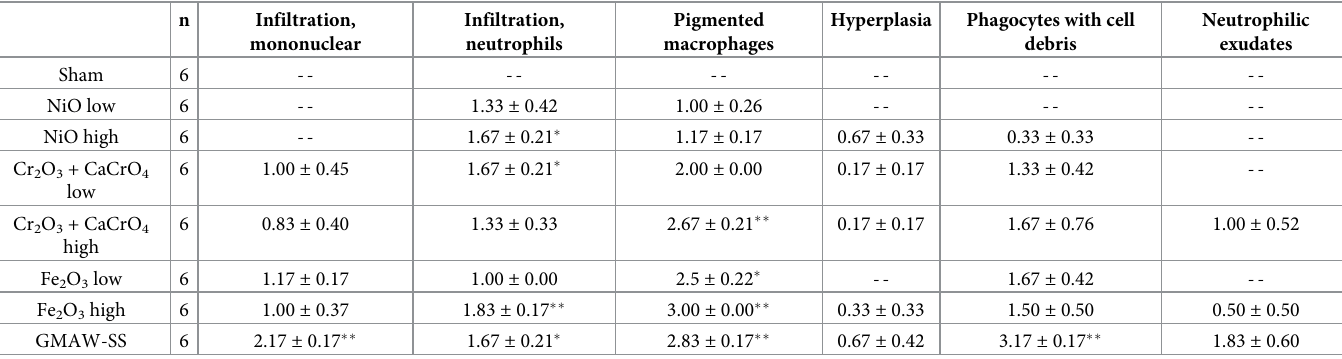
Table 6. Lung histopathology scores for the morphological findings in A/J mice at 1 day post-exposure to GMAW-SS fume or metal